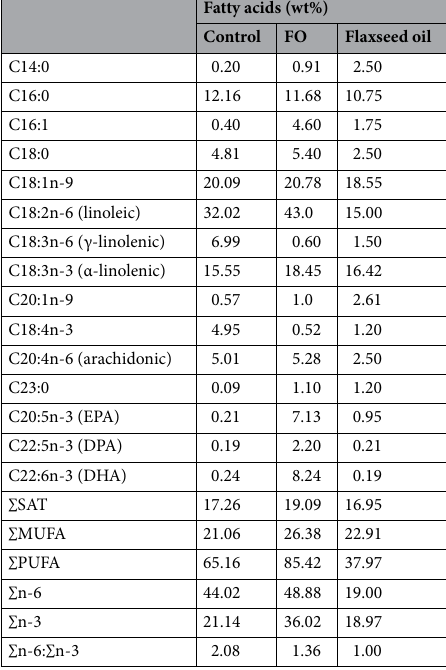
Table 9. Fatty acid composition of the diet mixtures used. ∑SAT sum percentage of saturated fatty acids, ∑MUFA sum percentage of monounsaturated fatty acids, ∑PUFA sum percentage of PUFA,